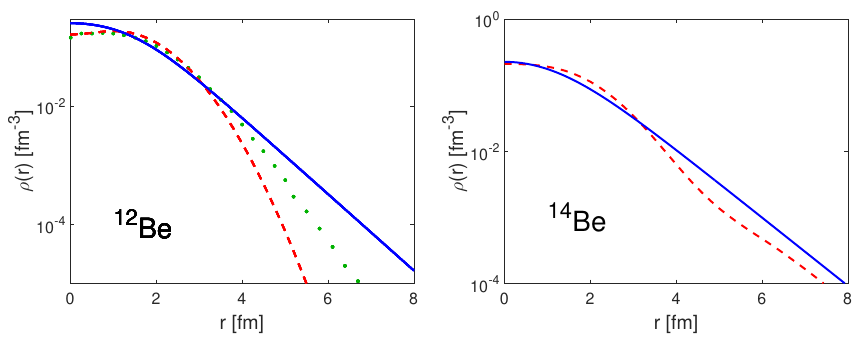
Figure 1. The 12 Be (left) and 14 Be (right) densities corresponding to the SF (blue solid), VMC (green dotted) and GCM (red dashed)